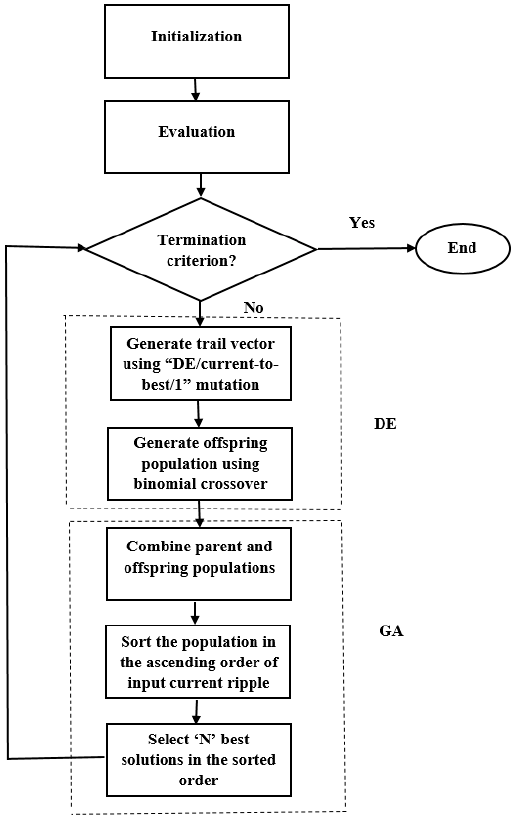
Figure 2. General framework of proposed method.